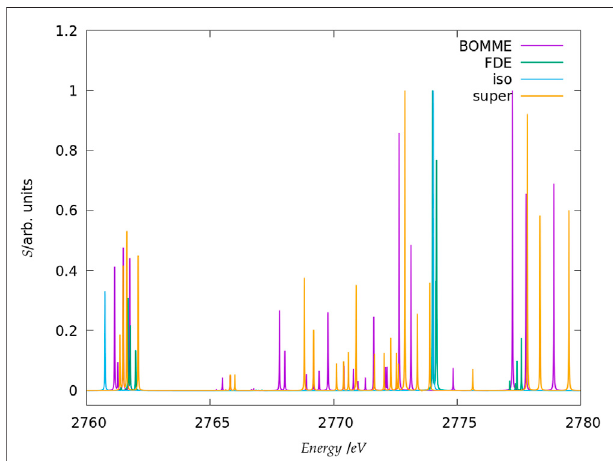
FIGURE 3 | Simulated K-edge spectra for the chloride model system, over the roughly 30 eV interval starting at the free ion edge peak. It should be noted that here the peak heights (in arbitrary units) for each family of models: free ion (=iso), FDE, BOMME, and supermolecule (=super) have been scaled, with a height of 1 assigned to the most intense